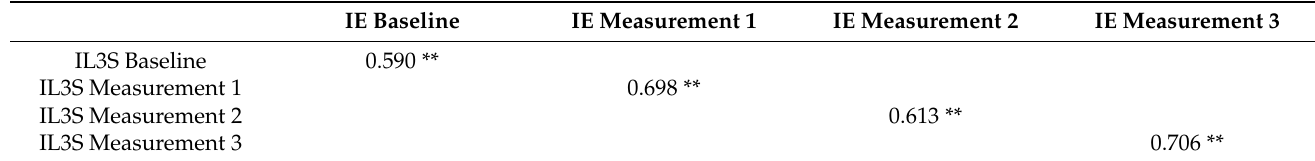
Table 3. Correlations between ideal L3 self (IL3S) and intended effort (IE) (Pearson’s r)—Intervention group.